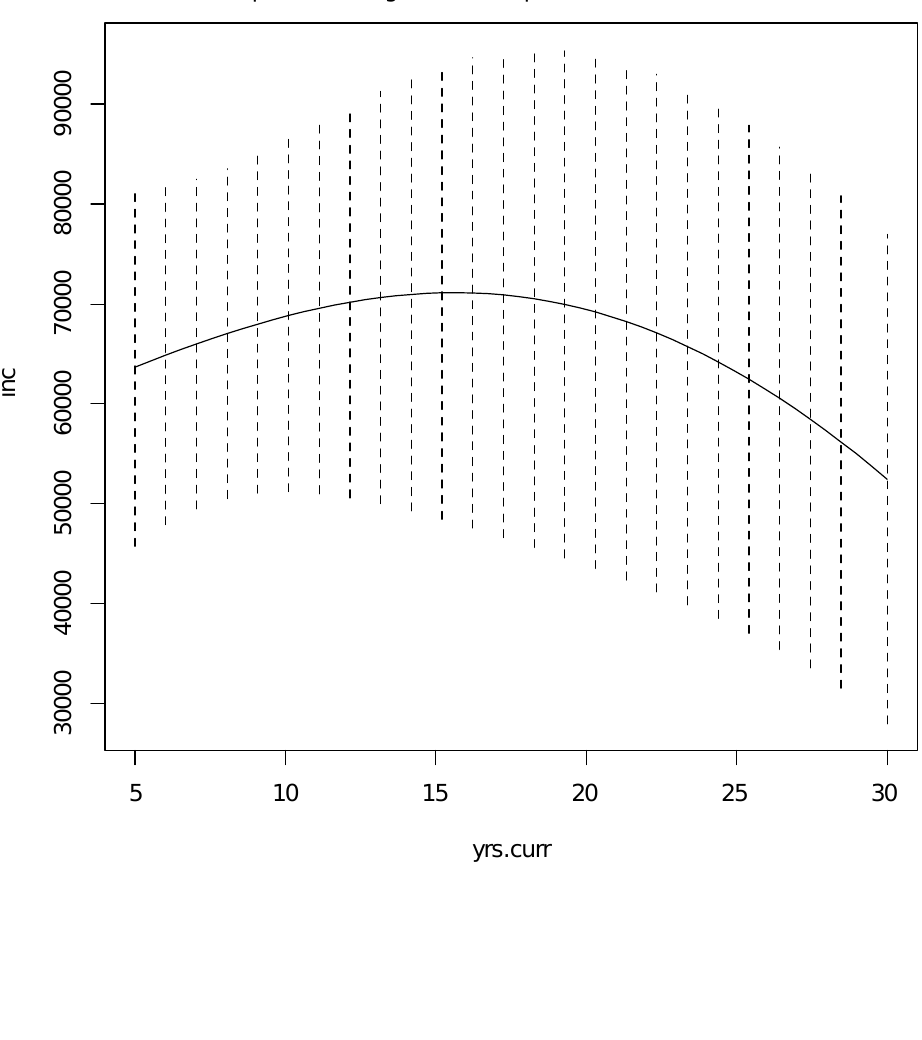
Nonparametric regression of experience on